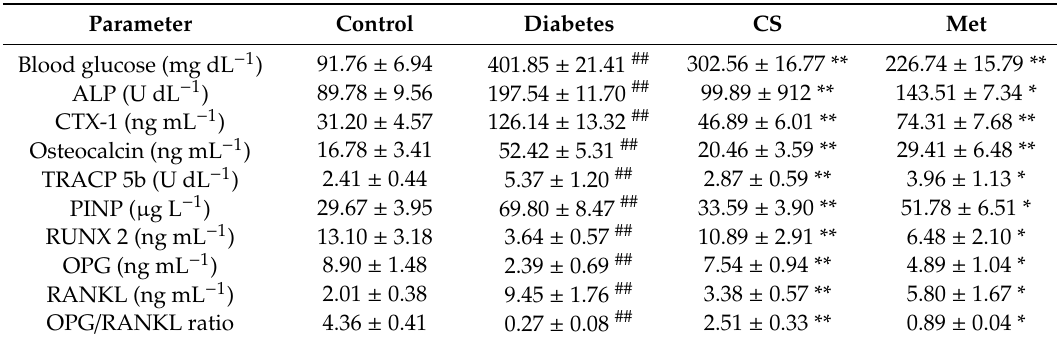
Table 1. Blood glucose and serum bone turnover markers in each group of rats at the end of the experiment.